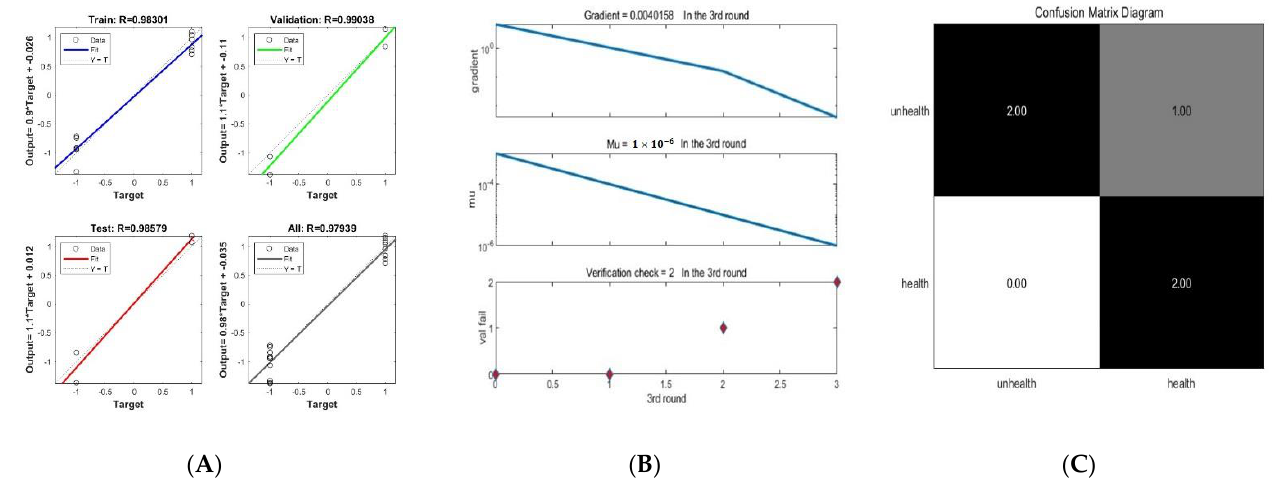
Figure 12. ( A ) Actual values of internal model training, internal validation and internal testing versus model output, ( B ) plot of training state values, and ( C ) confusion matrix.